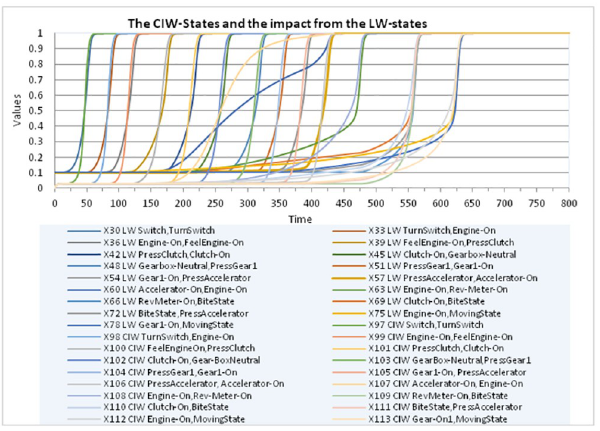
Fig 6. All control CIW-states showing impact from the corresponding observational learning LW-states.